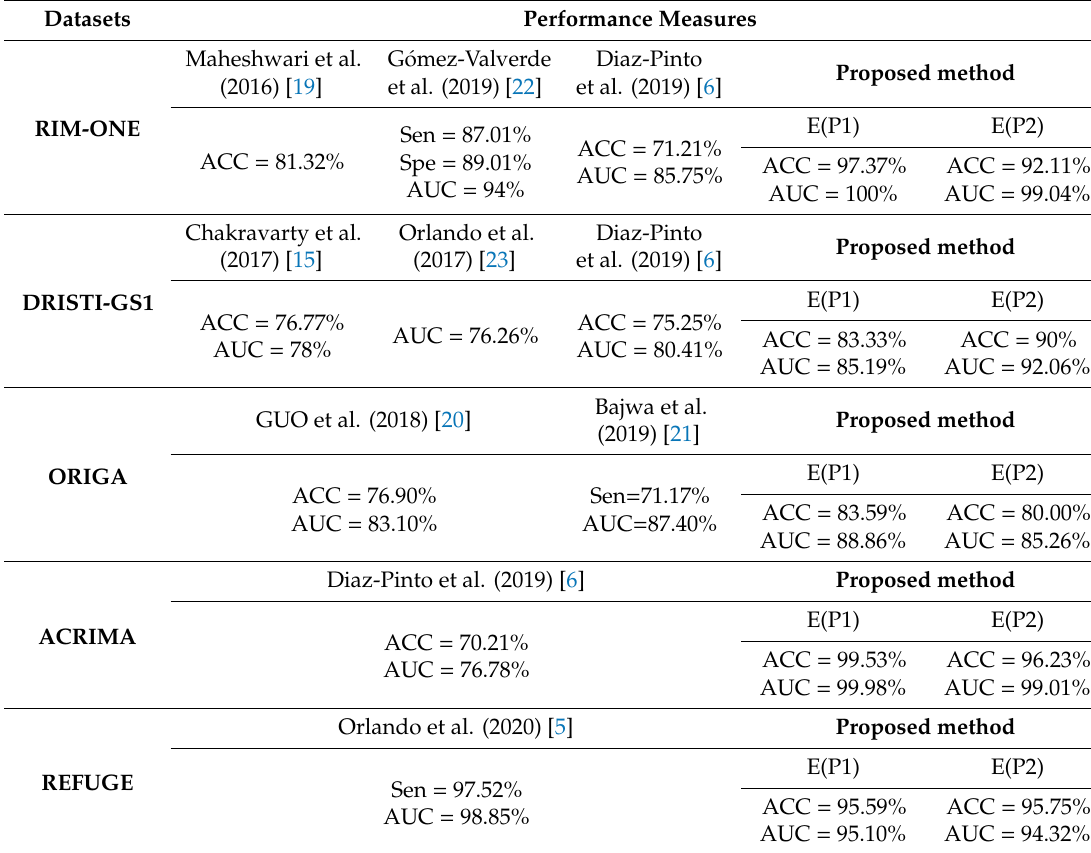
Table 8. Performance of the proposed methods for glaucoma